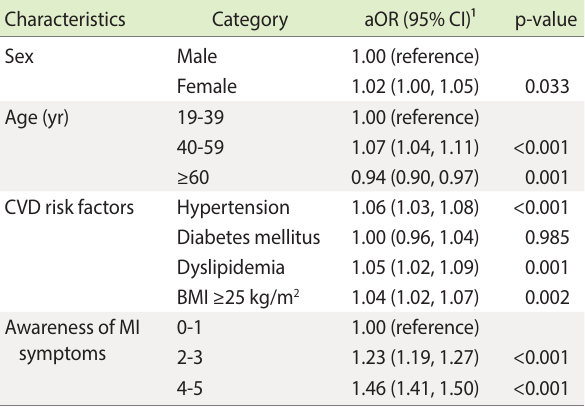
Table 3. Predictors of coping behavior at MI onset